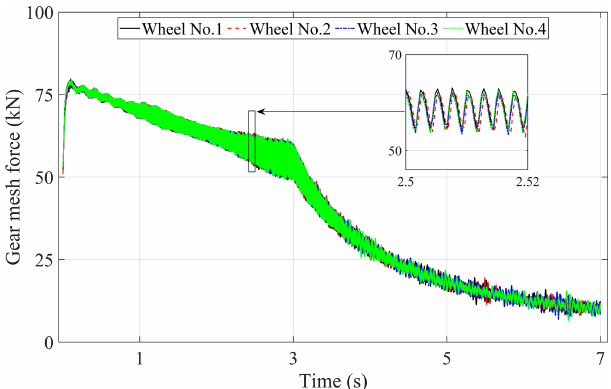
Figure 13. Dynamic mesh forces of the gear pairs under traction condition.